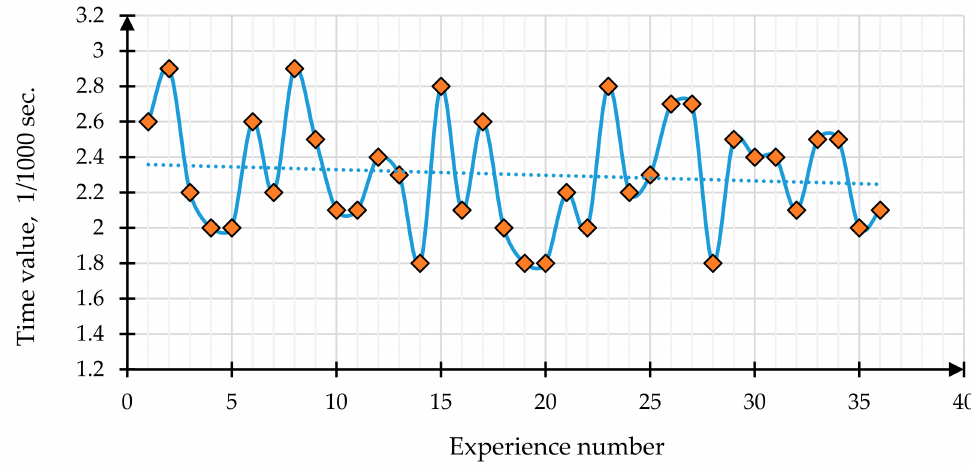
Figure 13. Neural network object classification speed